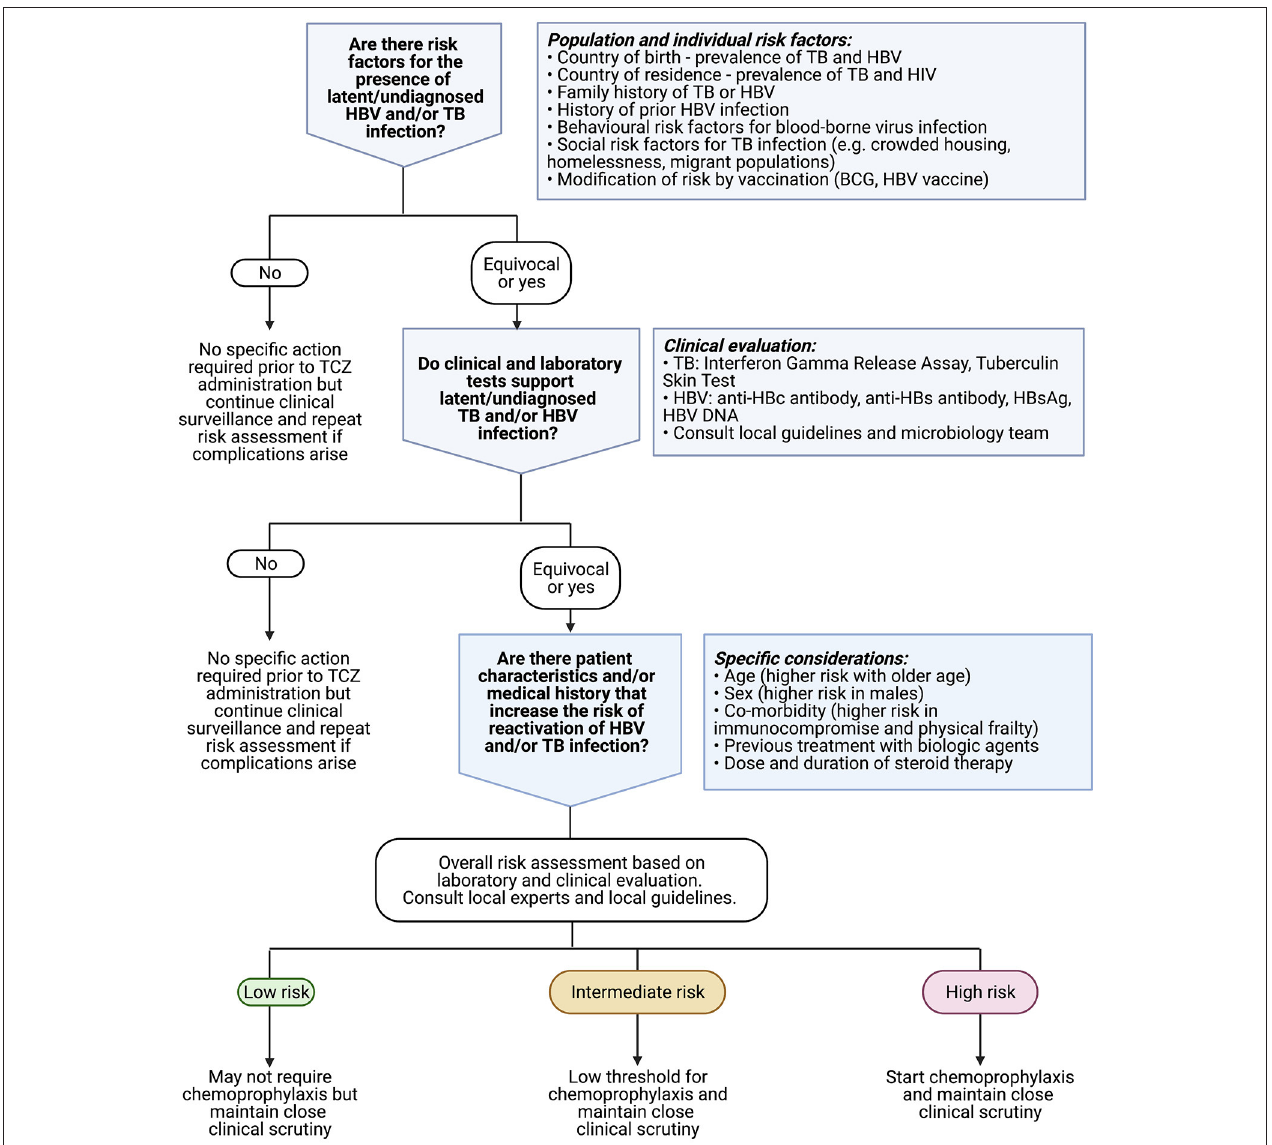
FIGURE 5 | Algorithm to underpin clinical approach to risk assessment for latent or undiagnosed TB or HBV prior to commencing treatment with TCZ. Existing recommendations for anti-cytokine therapy suggest considering antiviral prophylaxis especially in patients who are older in age, male sex, frail, and/or have underlying haematological malignancy (41). Clinicians should also consult relevant local guidelines for use of biologic therapy [e.g., (52)], and consider local epidemiology including vaccination coverage. Created with